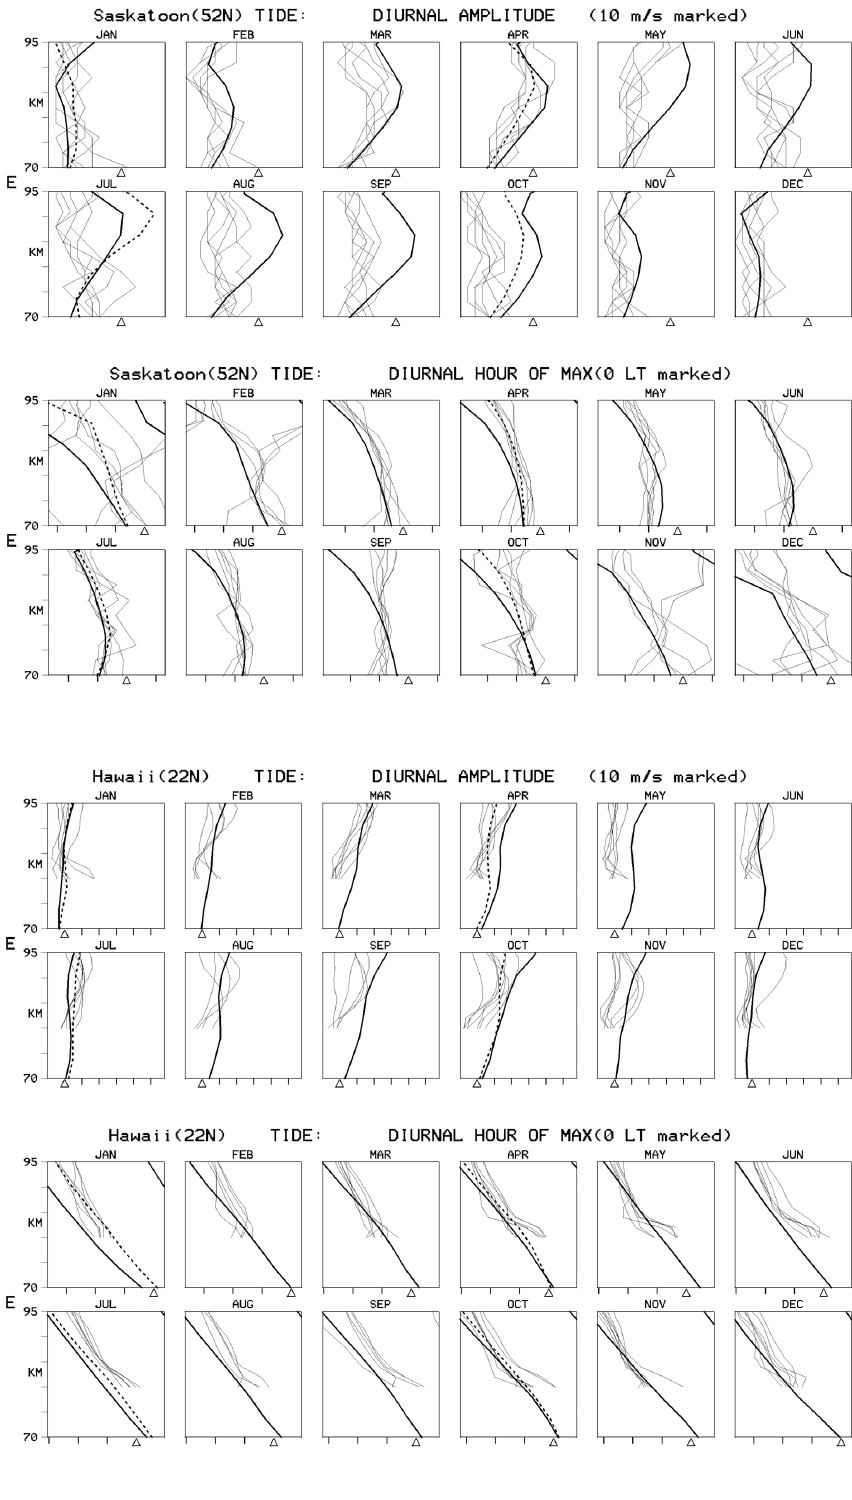
Fig. 7. Profiles as for Fig. 6, but for